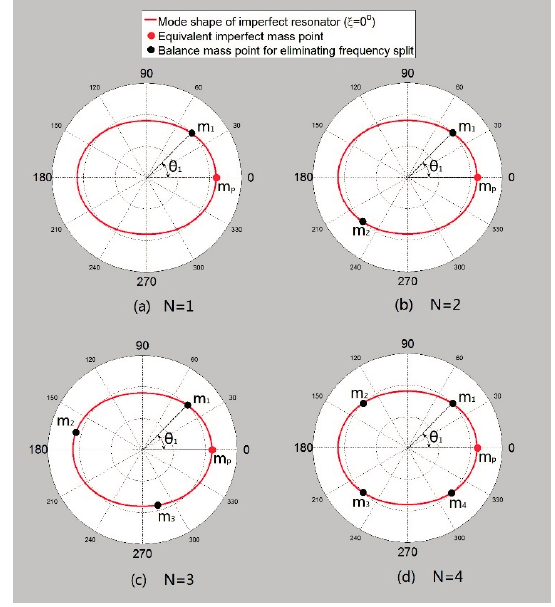
Figure 5. Distribution of equivalent imperfect mass point and balance mass points ( N = 1, 2, 3,